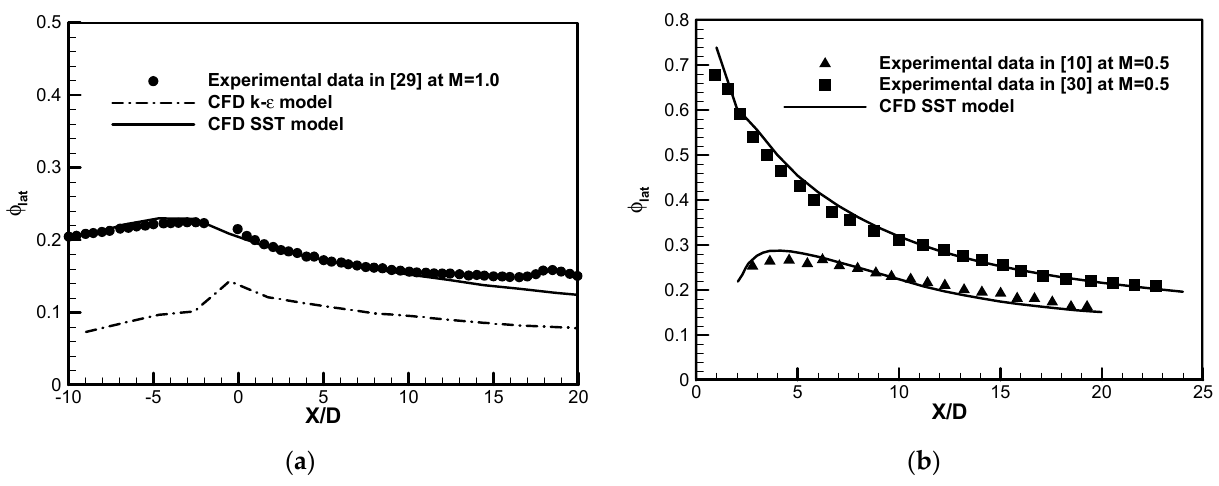
Figure 4. Turbulence model validation. ( a ) Laterally averaged overall cooling effectiveness; ( b ) Laterally averaged adiabatic cooling effectiveness.